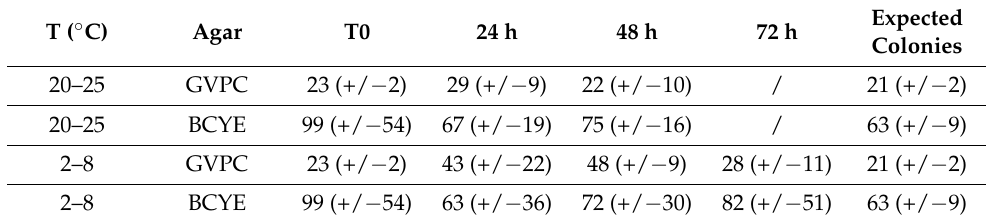
Table 1. Mean colony counts (+/ − SD) following inoculum of 0.1 mL/plate of 10 2 CFU/mL